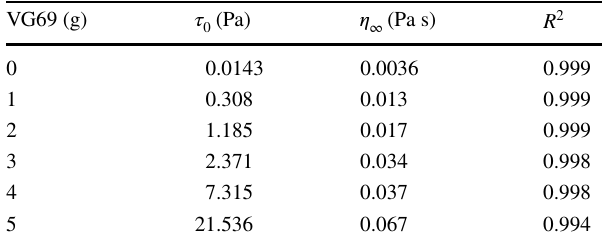
Table 5 Evolution of yield stress and viscosity at an infinite shear rate of gasoil-based drilling muds as function of VG69 organophilic clay quantity